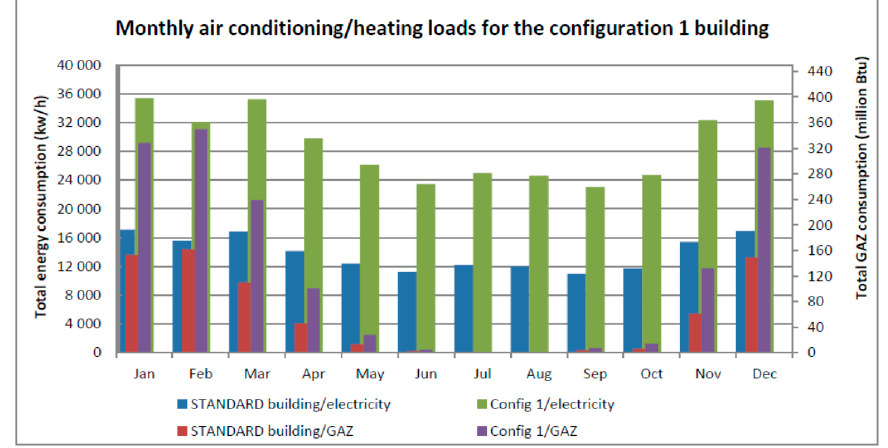
Figure 6. The monthly charges for air conditioning / heating for the configuration 1 building compared to those for the standard building.